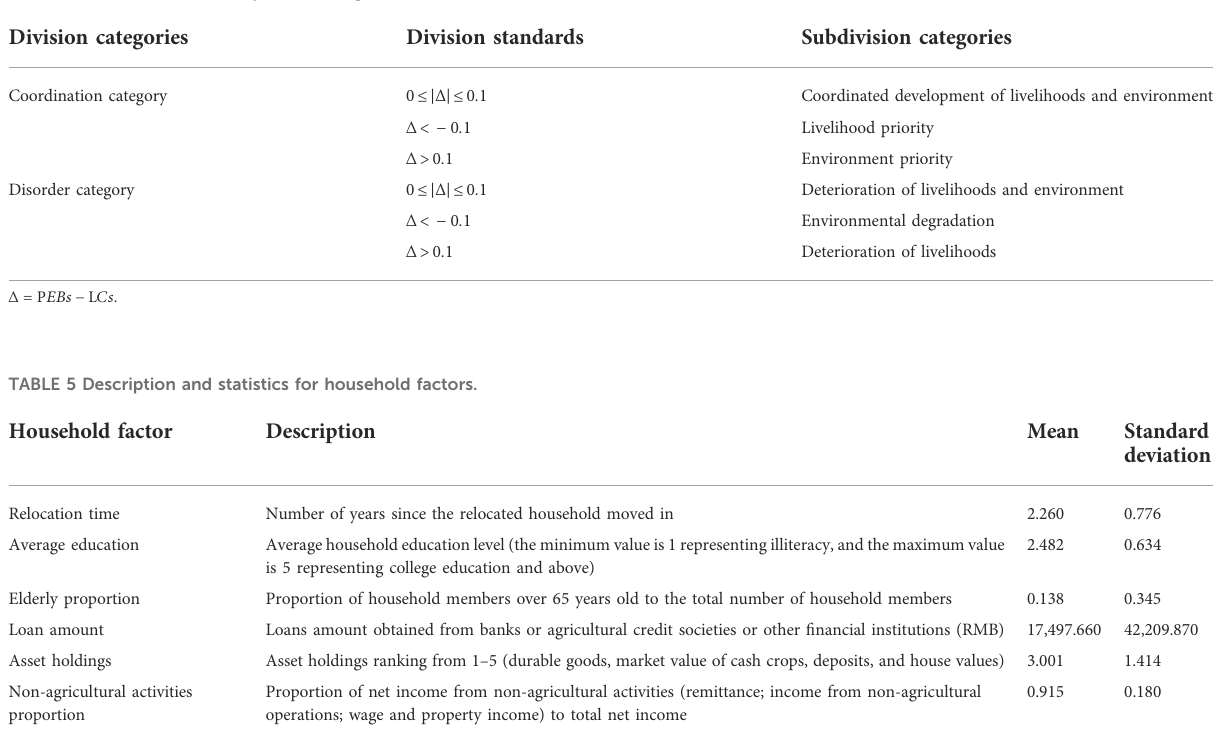
TABLE 4 Divisions of the comparison categories of “ livelihoods – environment ” links.